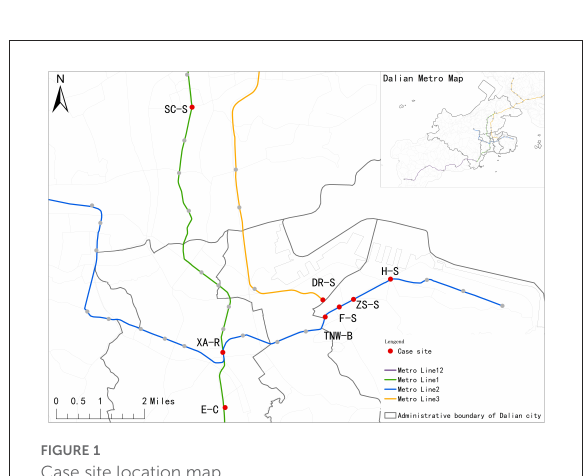
FIGURE1 Case site location